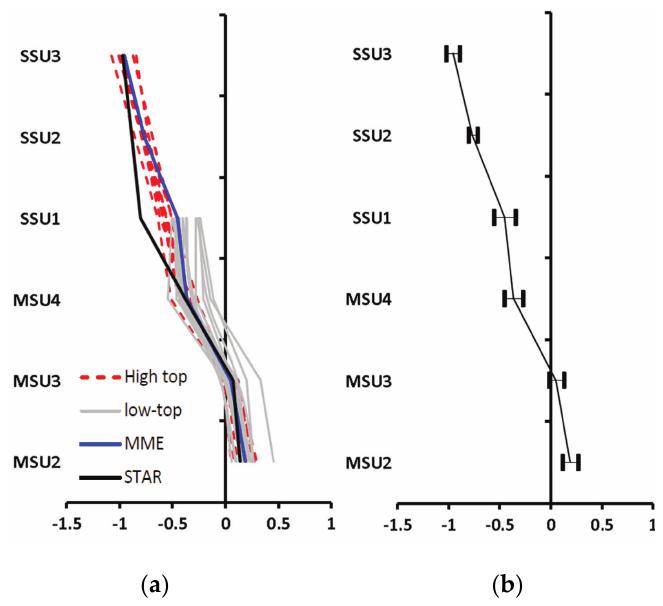
Figure 4. Vertical profile of global mean temperature trends and spread among the data sets for CMIP5 model simulations. Note SSU1-3 and MSU2-4 represent the SSU/MSU observational layers (unit K/decade). ( a ) Vertical profile temperature trends; ( b ) spread among models.